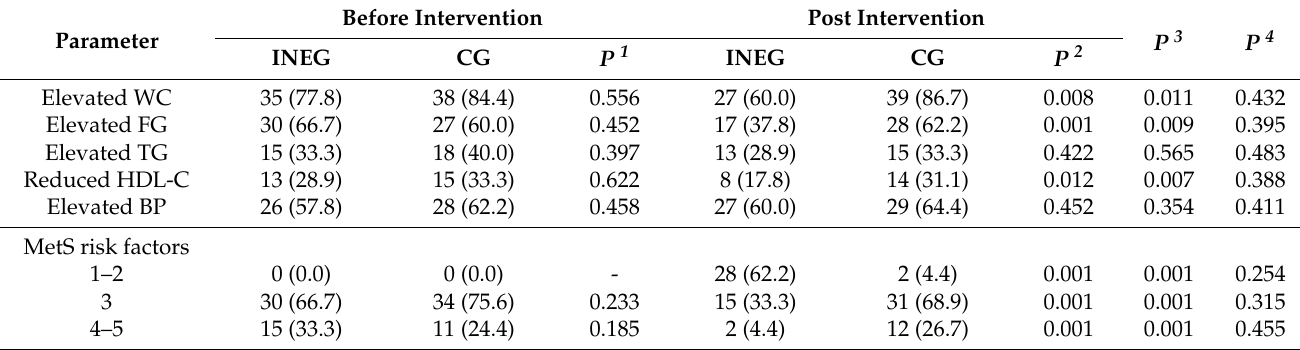
Table 5. Prevalence of MetS risk factors at baseline and 3-months post intervention.